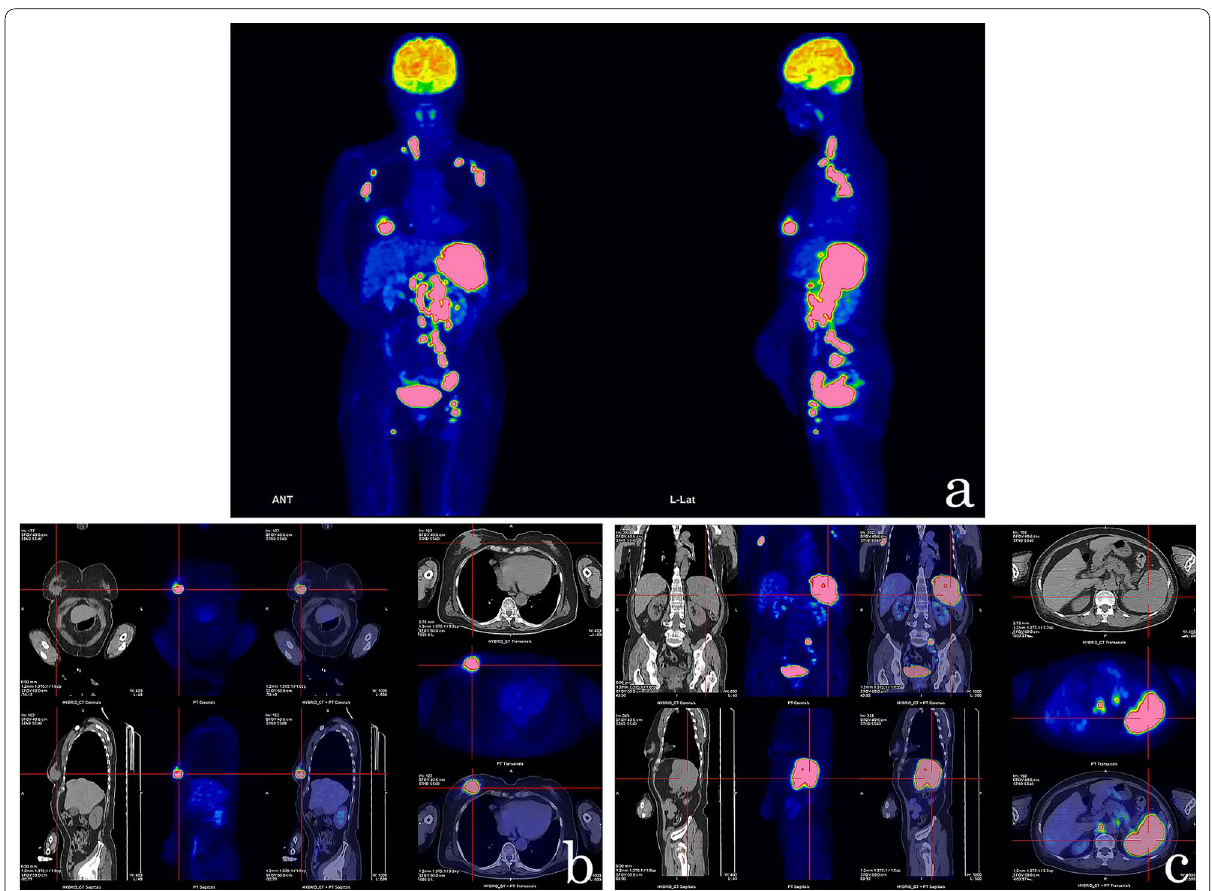
Fig. 3 Pre-treatment PET/CT findings. PET demonstrated an accumulation of 18F fluorodeoxyglucose in the right breast, bilateral axillary, right cervical, intra-abdominal lymph nodes, spleen, and bilateral inguinal lymph nodes. The findings of the a whole body, b right breast, and c spleen are